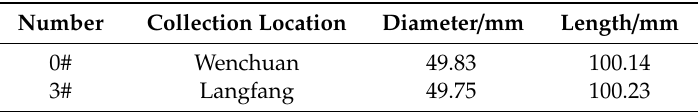
Table 1. Parameters of the